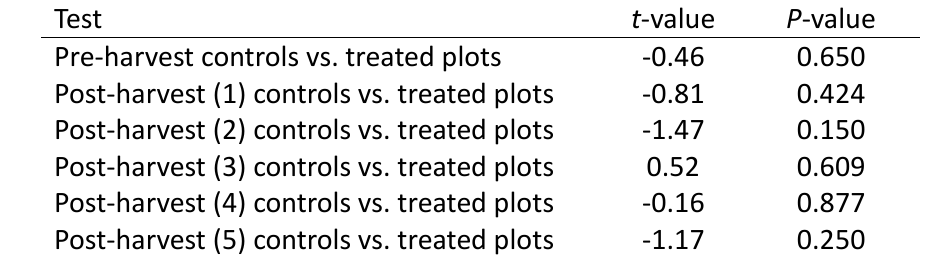
Table A1.2 . Year-specific treatment effects on density of Northern Parula, according to multiple comparison analyses (DF = 40).